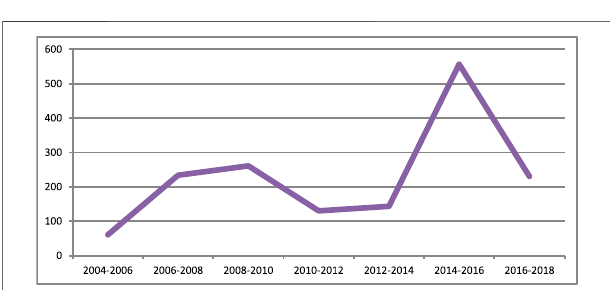
FIGURE 3 | Energy futures contract volatility during the sample period.